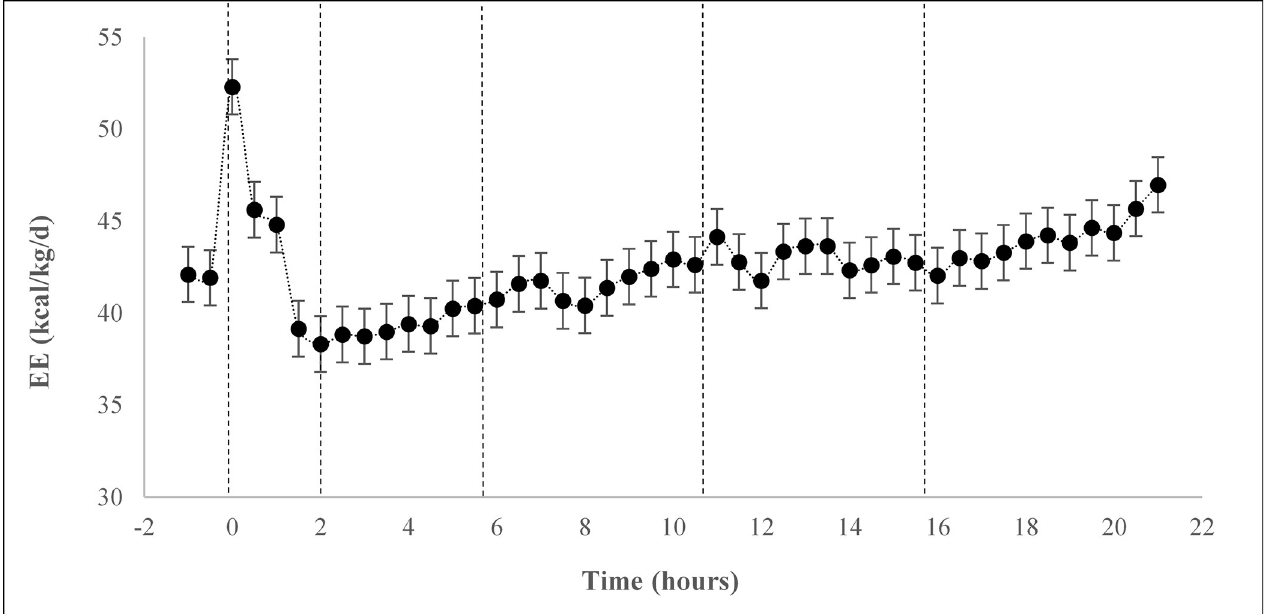
Fig 1. Average EE of cats (n = 19) consuming three experimental diets differing in PGR. Vertical dotted lines separate fasted, immediate postprandial, postprandial, fed, return to fasted and late fasted time points, respectively.